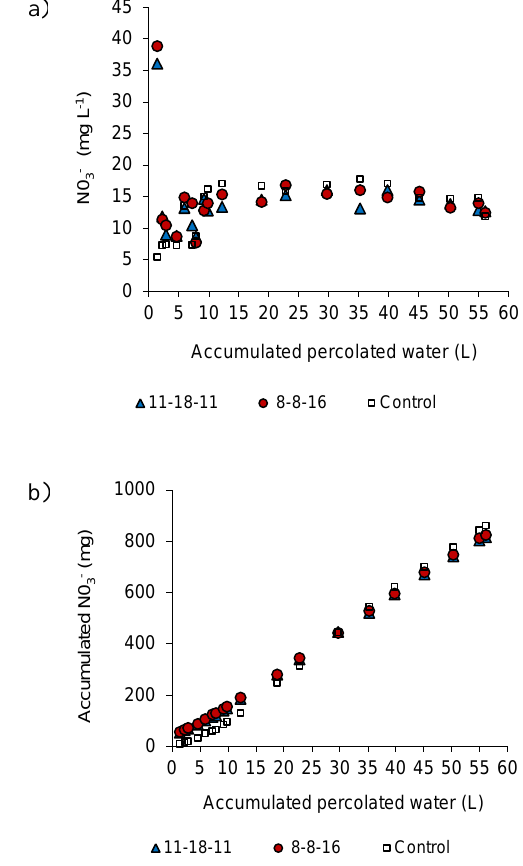
Figure 4. Nitrate concentrations in leachates (a) and accumulated NO 3- losses (b) from fertilized and control columns along the experiment (average of three replicates). 4